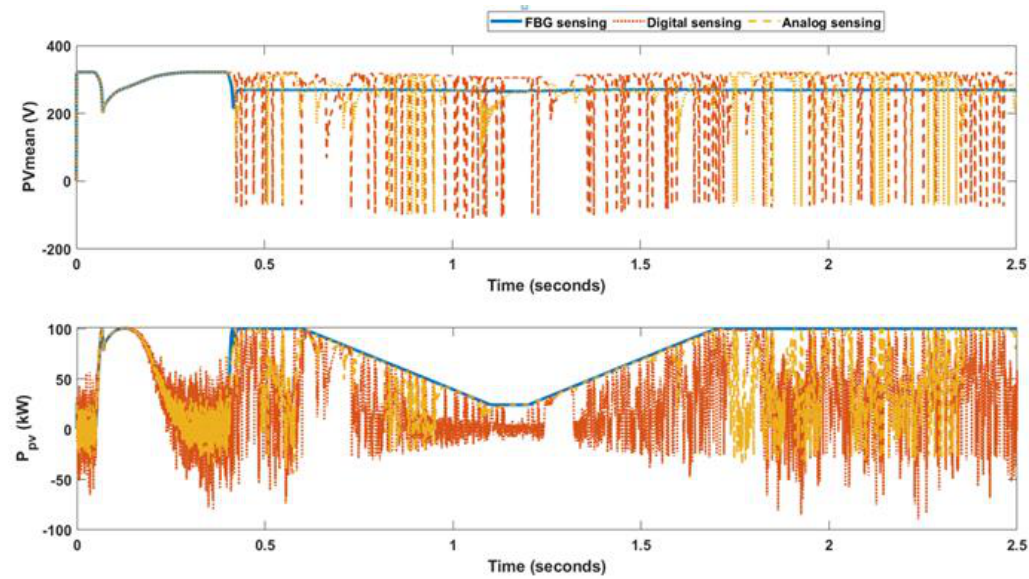
Figure 16. Output metrics at the potential point of PV array output under EMI.